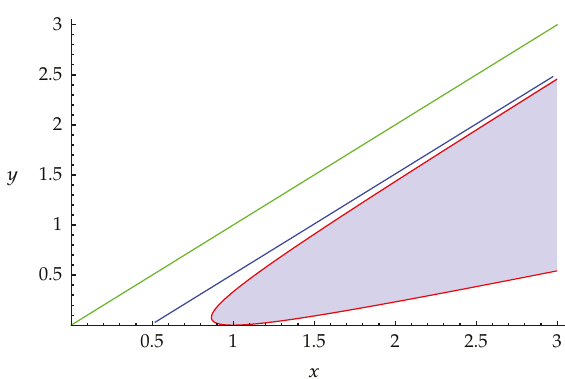
Figure 1: The shading area is denoted by μ (cid:2) x,y (cid:3) > 0. Otherwise, μ (cid:2) x,y (cid:3) < 0. The red curve is the graph